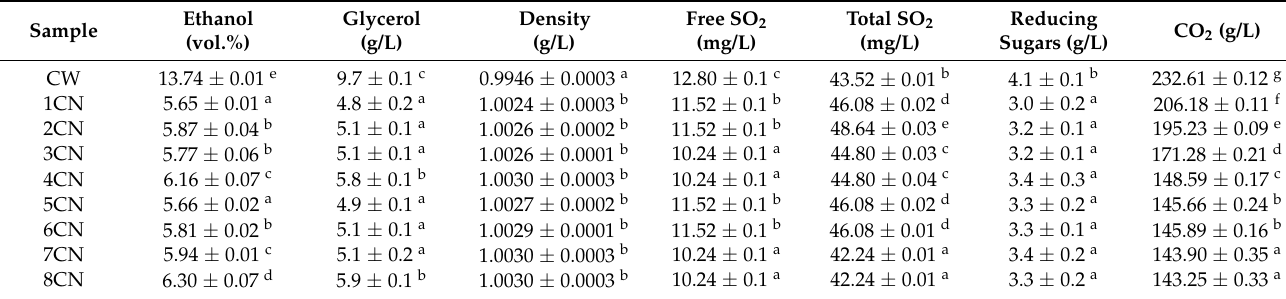
Table 5. Chemical composition of initial conventional Cabernet Sauvignon wine and nanofiltration retentates at 2.5, 3.5, 4.5 and 5.5 MPa with cooling and without cooling. Different superscript letters (a, b, c, d, e, f, g) in the same column represent statistically different values ( p < 0.05; ANOVA, Fisher’s (LSD) test).